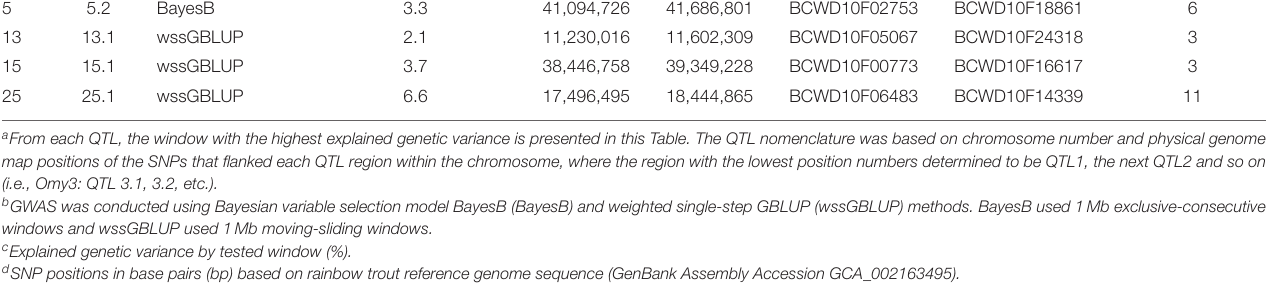
TABLE 4 | Summary of QTL associated with BCWD survival STATUS in NCCCWA population detected using RAD-SNPs genotyping. Omy QTL a GWAS method b Genetic variance (%) c Physical Map (bp) d Markers in Window SNPs per window